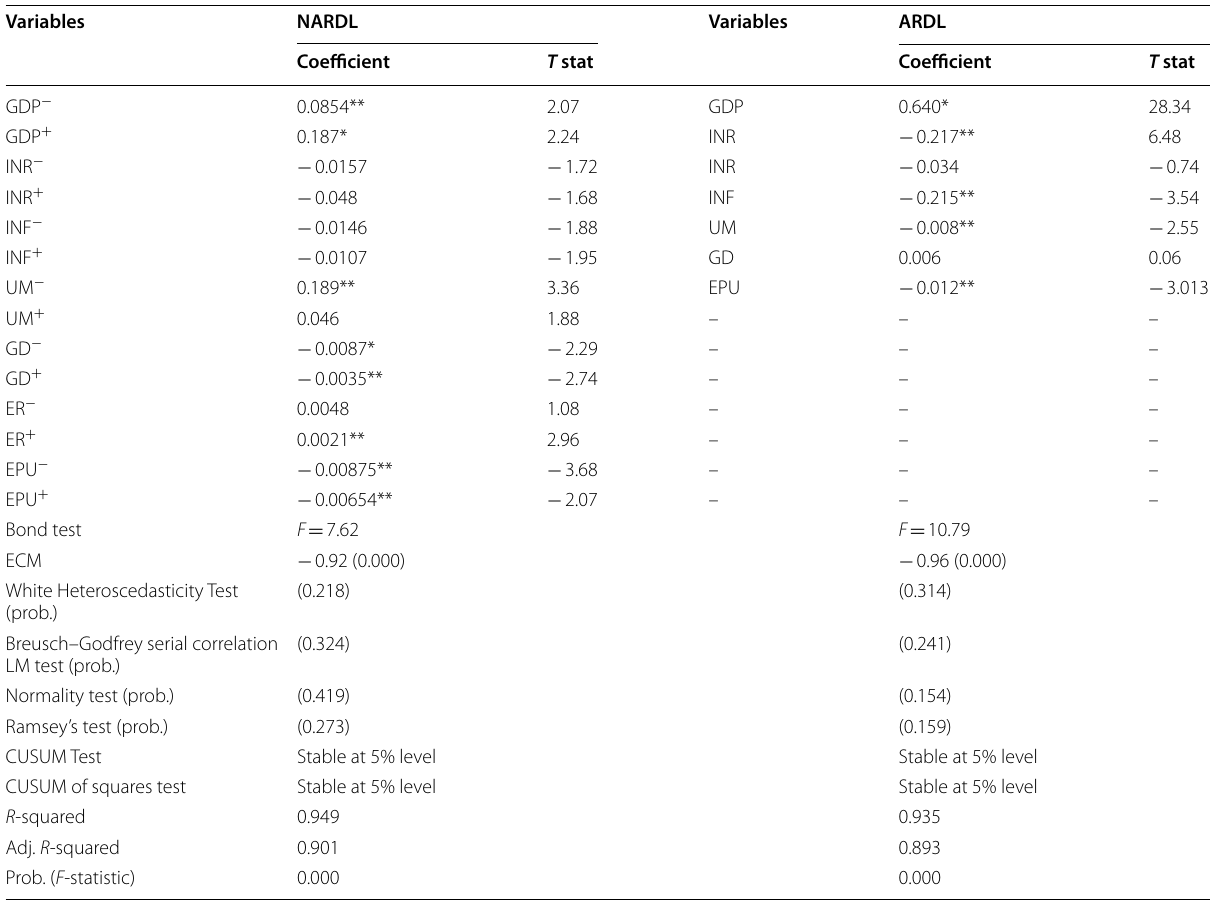
Table 4 ARDL and NARDL model results